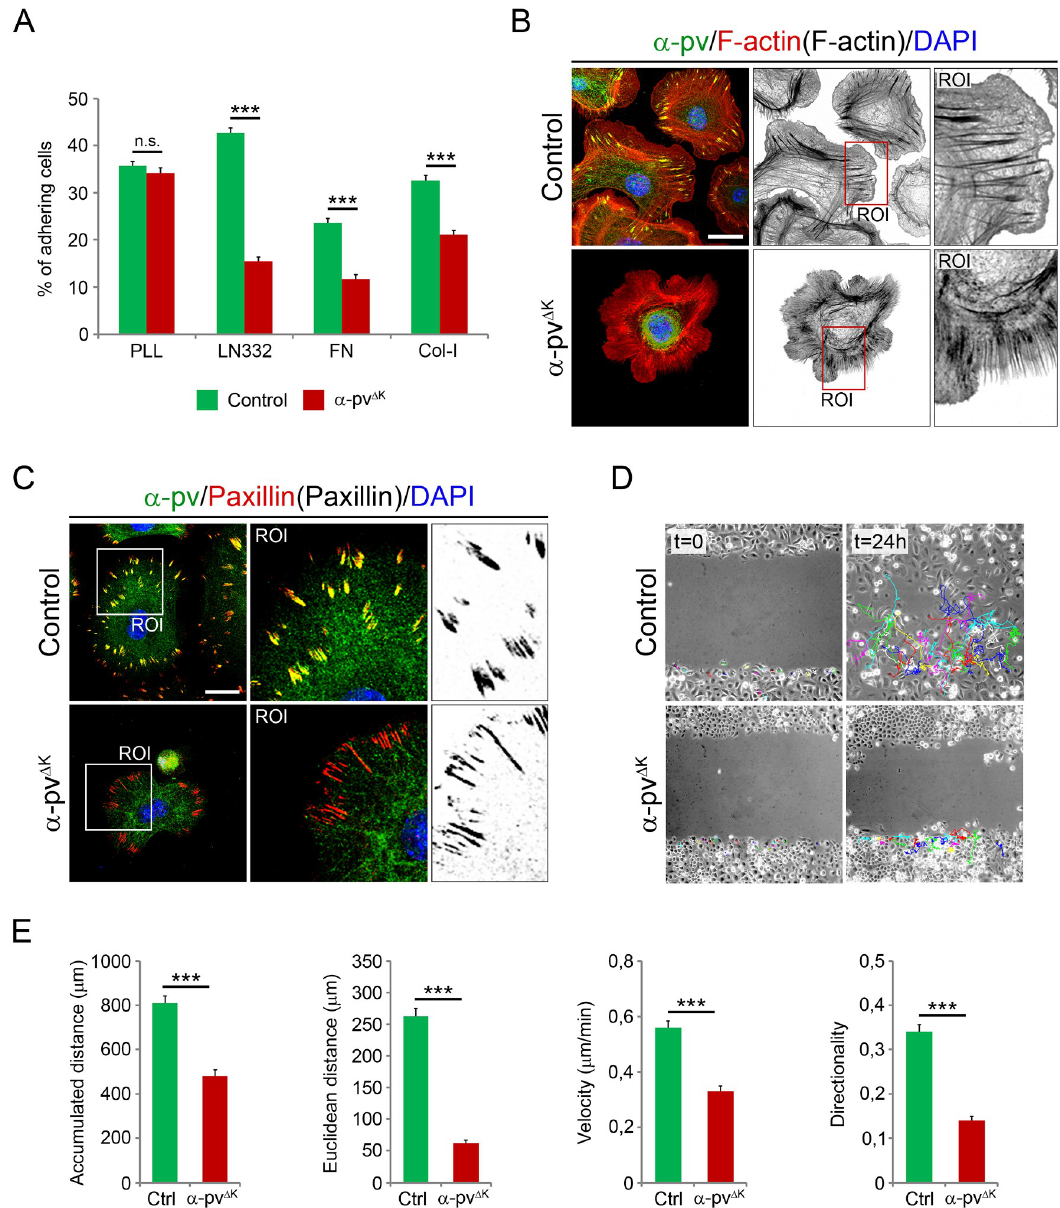
Fig 6. Adhesion and migration of α -pv-deficient keratinocytes. ( A ) Quantification of adhesion of control and α -pv-null keratinocytes to PLL, LN332, FN and Col-I. Values represent means of the percentage of adhering cells + SD. At least three independent adhesion assays were performed. ( B ) Double-fluorescent labeling for α -pv and F-actin of control and α -pv-null keratinocytes cultured on fibronectin. Nuclei were visualized with DAPI. ( C ) Double-fluorescent labeling for α -pv and paxillin of control and α -pv-null keratinocytes cultured on fibronectin. Nuclei were visualized with DAPI. ( D ) Scratch wounding of a confluent monolayer of control and α -pv-null keratinocytes. ( E ) Quantification of migration parameters as indicated. Values represent means +SD. At least three independent scratch assay experiments were performed and more than 20 individual cells were tracked in randomly chosen regions in each experiment. express low levels of α 2 β 1 and α 5 β 1 integrins, which together with α 3 β 1 are required for estab- lish and maintain the integrity of the BM [6, 8, 18]. The interaction of LN-332 with β 1 integ- rins results in the assembly of FAs, whereas its binding to α 6 β 4 integrin results in the formation of hemidesmosomes [5]. The parvin-containing IPP complex associates with β 1 and